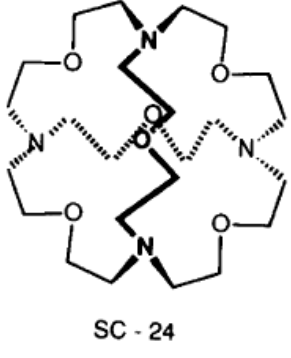
Figure 6. Structure of SC-24.